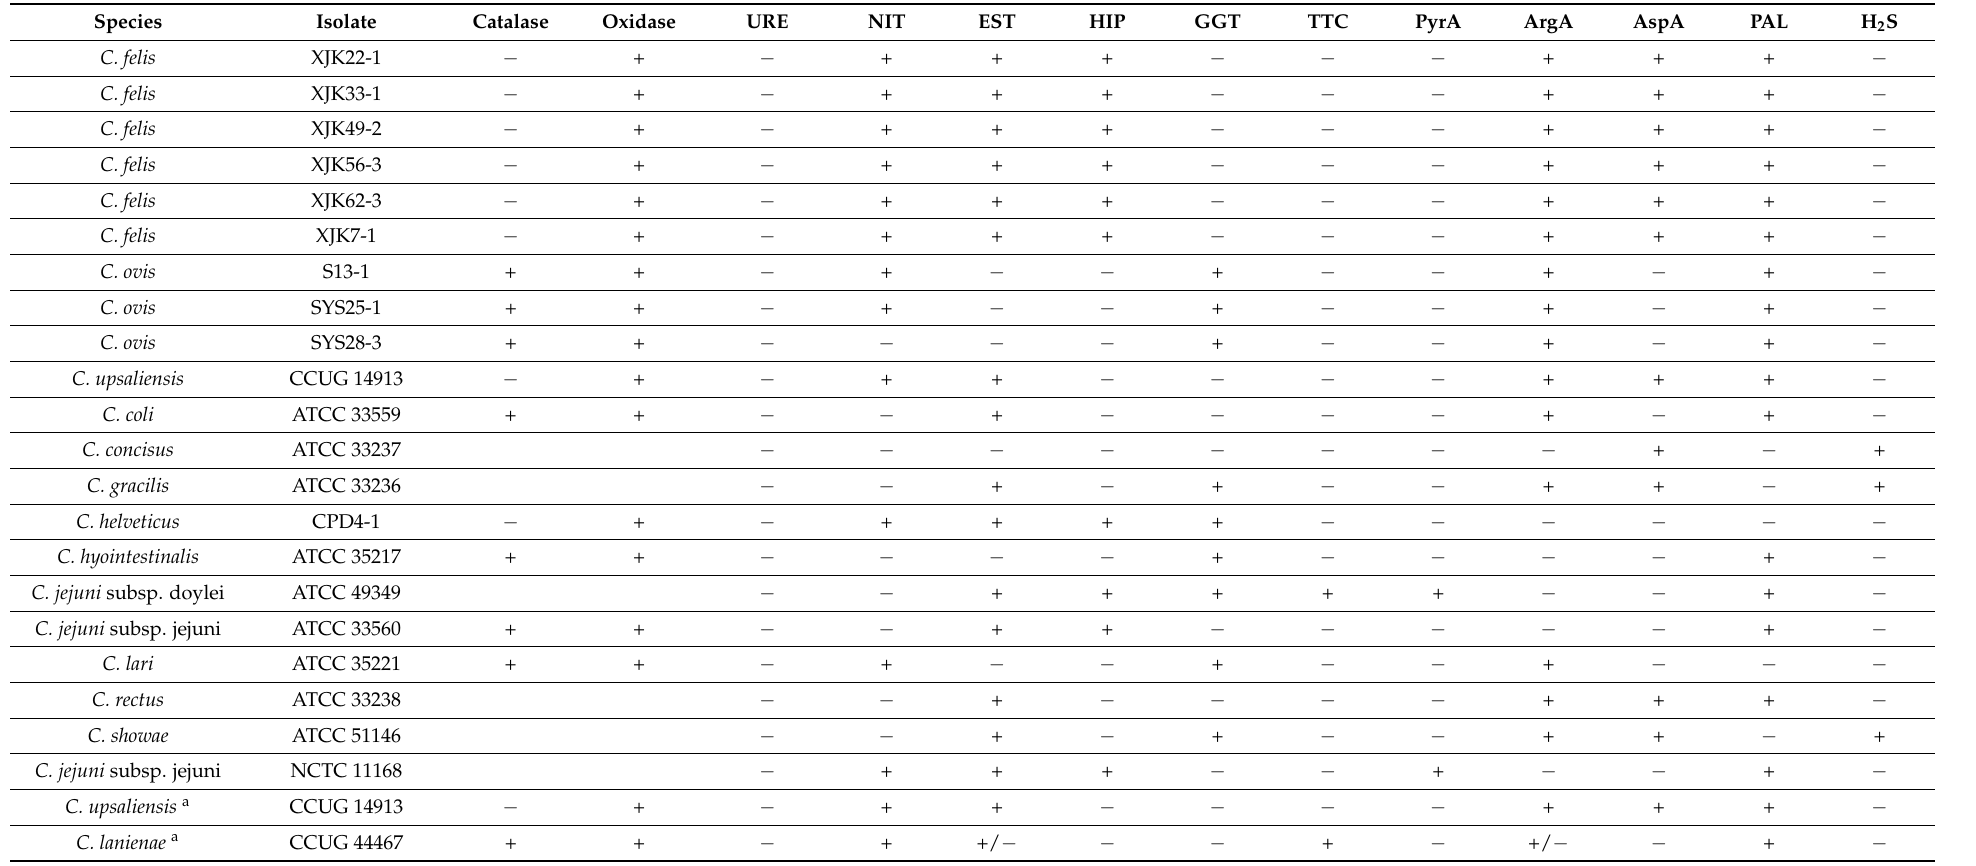
Table 3. Phenotypic characteristics of Campylobacter felis sp. nov. strains, Campylobacter ovis sp. nov. strains, and the type strains of related